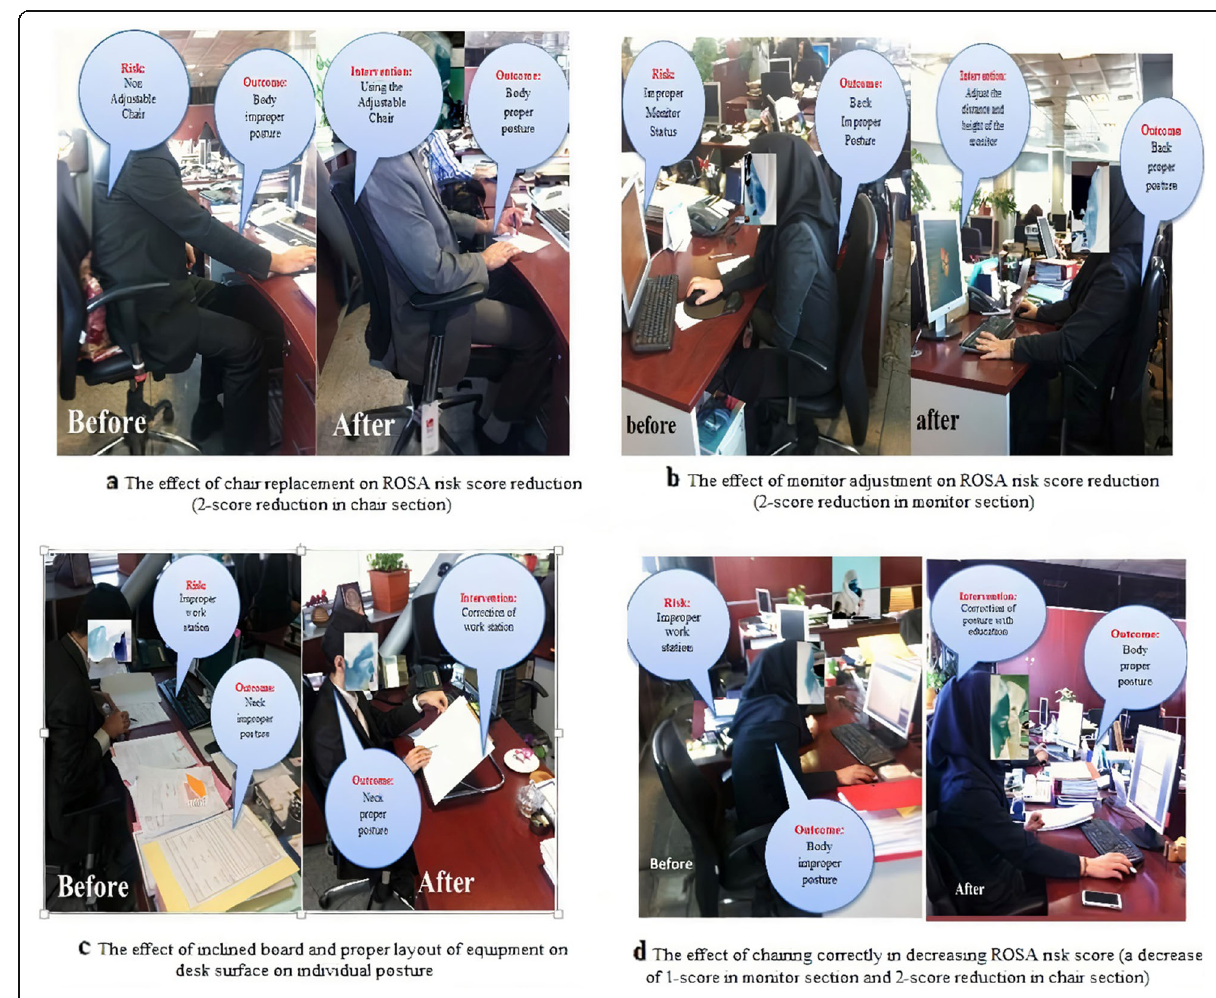
Fig. 3 The sample of intervention activities (before and after